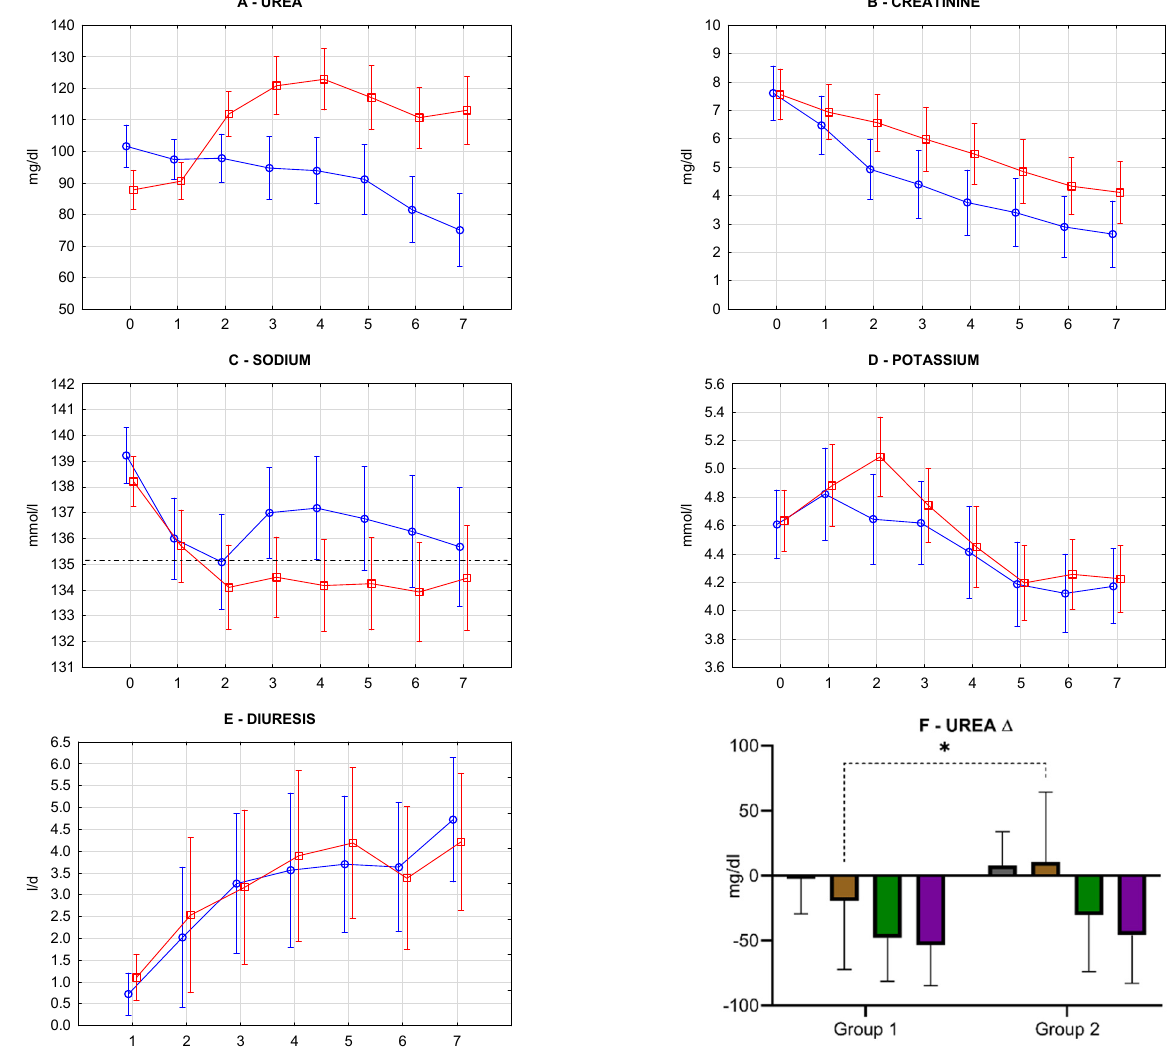
Figure 8. Mean kidney function parameters in following measures—7-day observation (rANOVA, N = 66, Group 1 (HMP) n 1 = 26, Group 2 (SCS) n 2 = 40), T —standard error (SE)): ( A ). urea ( * p = 0.00006 ), ( B ). creatinine ( p = 0.055), ( C ). sodium ( p = 0.466), ( D ). potassium ( p = 0.429), ( E ). diuresis ( p = 0.835). ( F ). urea concentration relative changes (Δ), ( t test for independent groups, CI 95%): day1–day0 ( p = 0.135), day7–day1 ( * p = 0.029 ), month1–day1 ( p = 0.087), month3–day1 ( p = 0.643).